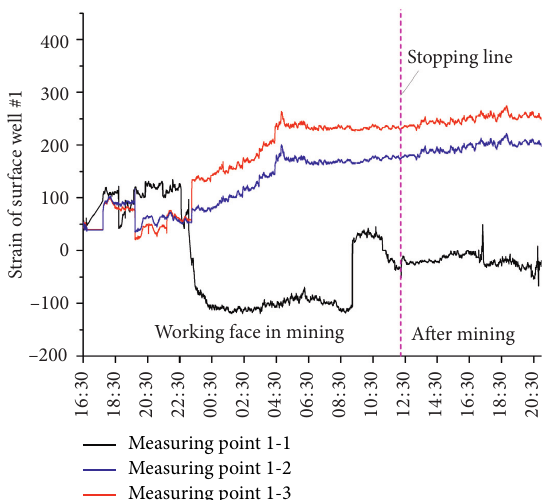
Figure 14: Strain of surface well #1 (the PE pipe) (tensile strain is positive and compressive strain is